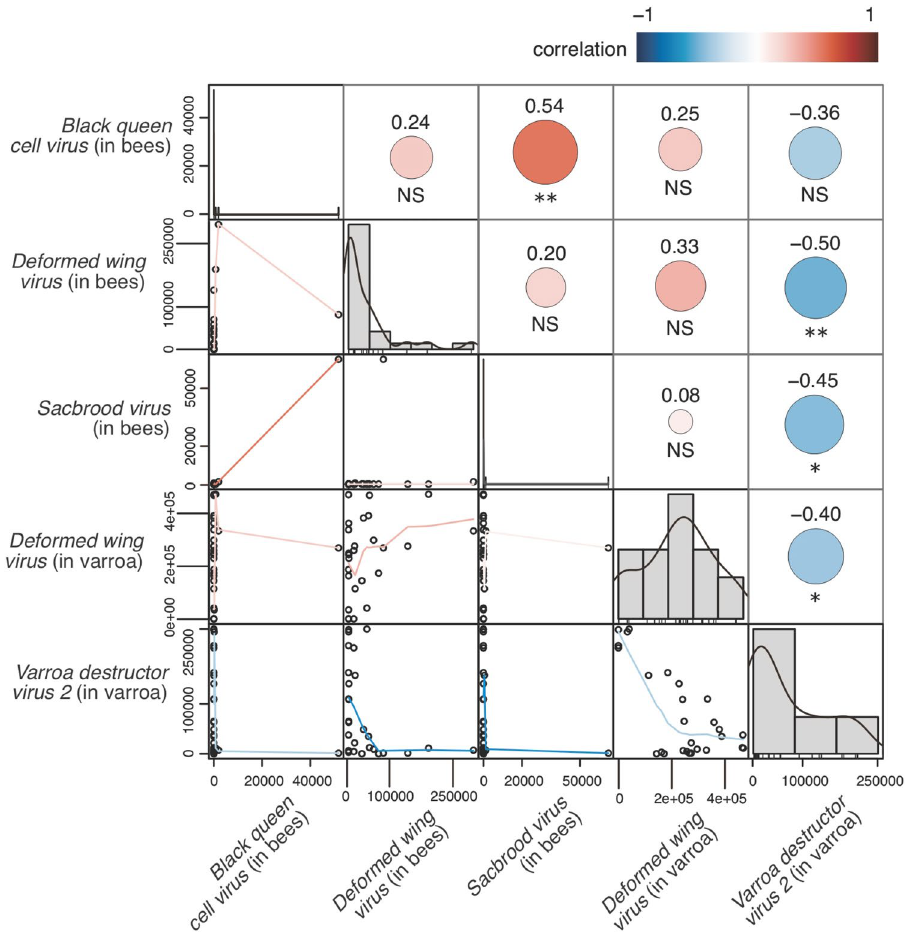
Figure 3. Pairwise correlations between virus loads in honey bees and V. destructor . The V. destructor and bee samples were paired, taken from the same hive. The size of the circles is representative of the Spearman correlation coefficient, which is shown above each circle with statistical significance indicated below. Only viruses that were identified in the PCA as important in explaining the variation in the communities were used in the analysis. * p < 0.05; ** p < 0.01. The counts are in transcripts per million.